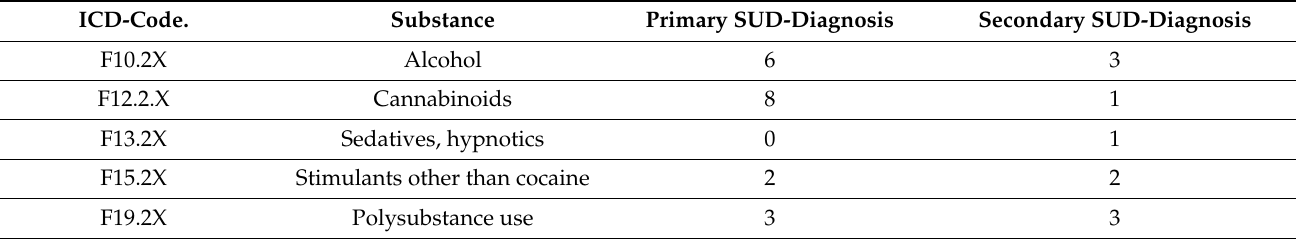
Table A1. Substance use disorder diagnosis (SUD) (ICD-10) in study sample.